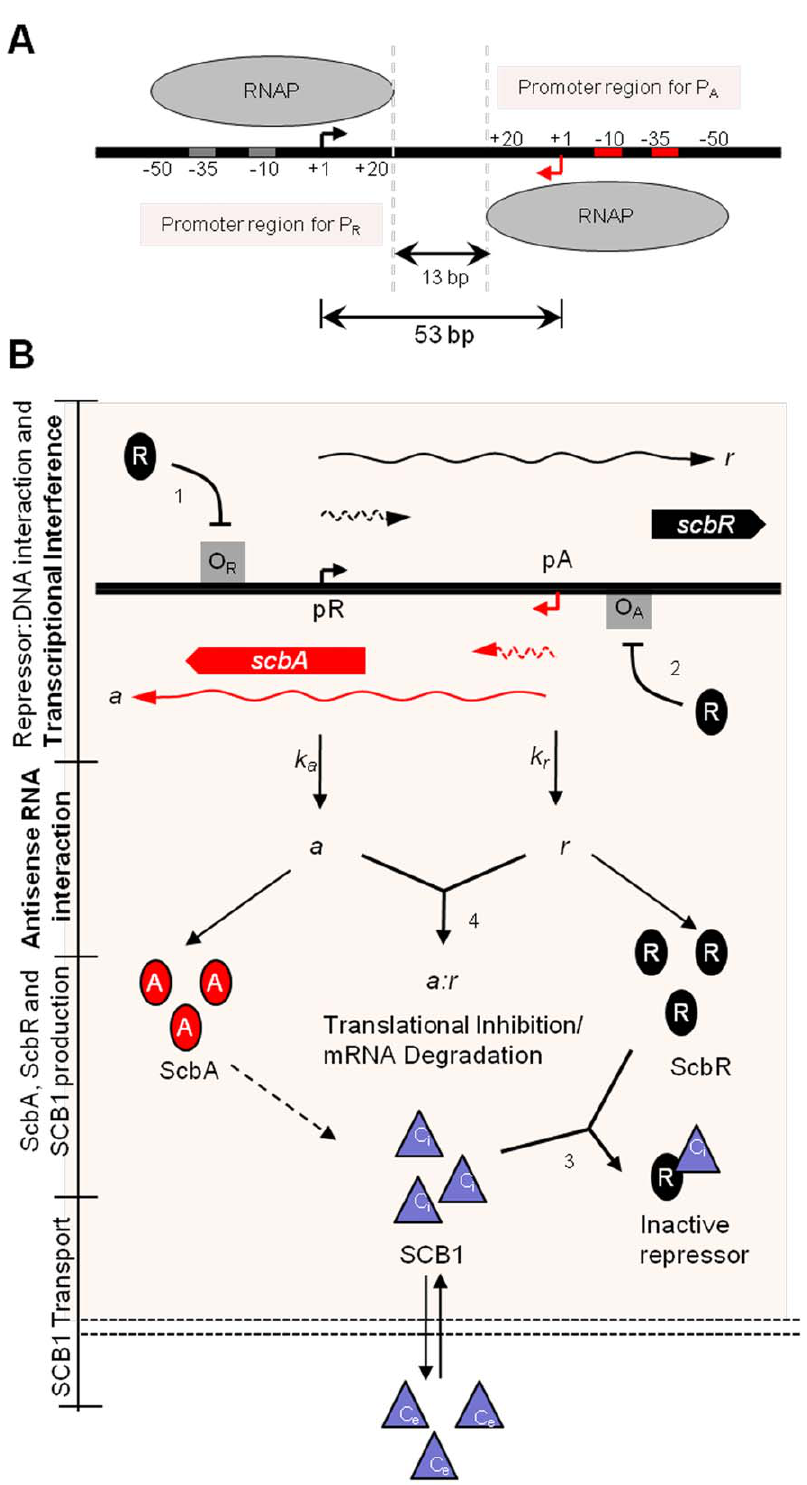
Figure 1. Convergent transcription in the scbA-scbR gene regulatory network. ( A ) Schematic of the promoter regions for pA and pR, and RNAP footprint at the respective promoters. ( B ) The scbA-scbR gene regulatory network. Convergent promoter pA-pR drive expression of genes scbA (shown in red) and scbR (shown in black) present on the opposite DNA strands (shown by black lines) to give rise to full-length transcripts a and r (RNA denoted by curved lines) and short truncated RNA (denoted by dashed-curved lines) respectively. Transcriptional Interference model: Collision between elongating RNAPs and between an elongating RNAP and a stationary RNAP at the opposing promoter causes transcriptional termination and results in the generation of short truncated transcripts (dashed-curved lines) from promoters pA and pR respectively. Full-length transcripts a and r result when elongating RNAPs escape collision. Antisense Regulation: Hybrid RNA complexes formed between full-length a and r RNA result in translational inhibition or mRNA degradation. Protein ScbR (R) can repress transcription from pA and pR (indicated by blunt arrows) by